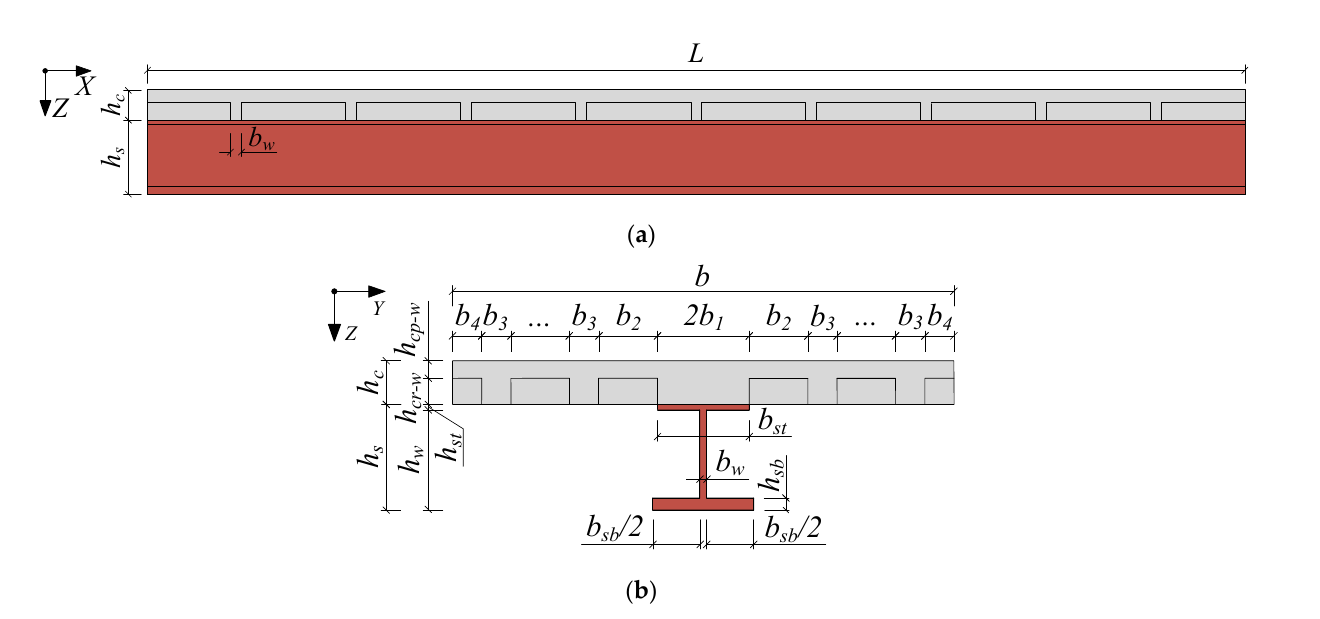
Figure 2. The SU-WSCS: ( a ) elevation; ( b ) cross section. First, the transverse ribs in SU-WSCS are converted to the longitudinally ribbed slab according to the principle of constant volume, as shown in Figure 3. In this way, the equivalent thin plate thickness h cp and the longitudinal rib height h cr of the UHPC slab can be calculated using Equations (1) and (2), respectively, where L represents the span length. It is noted that there is no change in their width. The distance between the neutral axis of the UHPC slab and the neutral axis of the steel bottom flange plate is defined as h . Assume that there are a number of n longitudinal ribs, so the total width of that, b r can be calculated according to Equation (3).